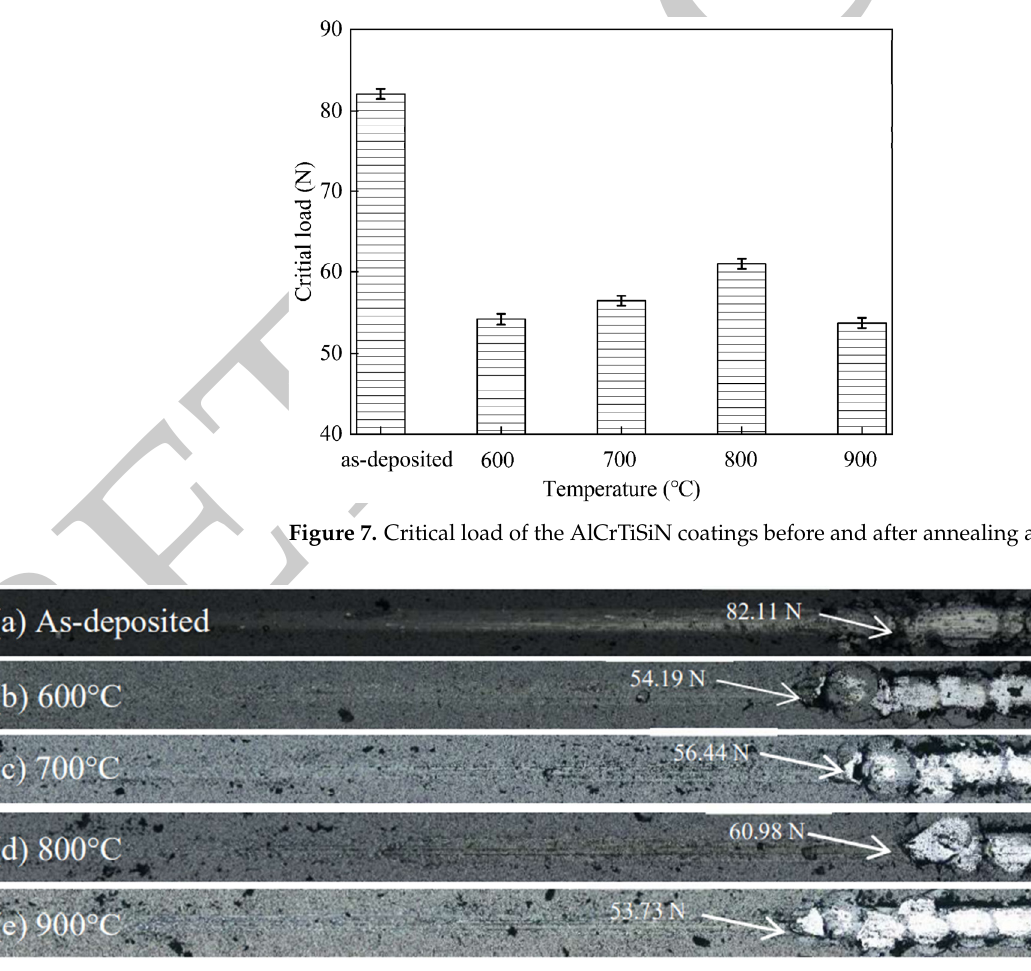
Figure 8. Scratch morphologies of the AlCrTiSiN coatings before and after annealing: ( a ) the range of normal load is 0–120 N, ( b – e ) the range of normal load is 0–80 N; locally amplified scratch mor- phologies ( f ) as deposited, ( g ) annealed at 800 °C. 3.4. Tribological Behaviors Figure 9 shows the average friction coefficient of the AlCrTiSiN coatings before and after annealing at different temperatures. They varied in the range of 0.66–0.69, and no